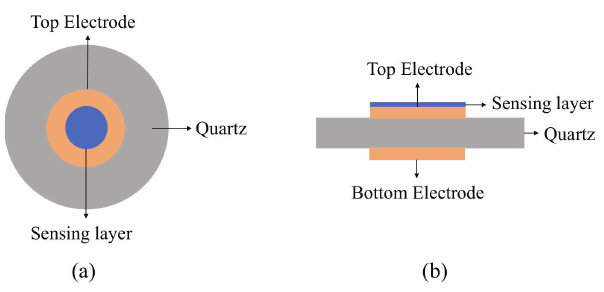
Figure 7. Schematic view of a typical QCM sensor ( a ) top view and ( b ) side view. The quartz crystal resonator is sandwiched between two gold electrodes (yellow). The thin film sensing layer on the top of QCM structure (blue) attracts analytes, changing the mass, measuring through sensor resonance frequency